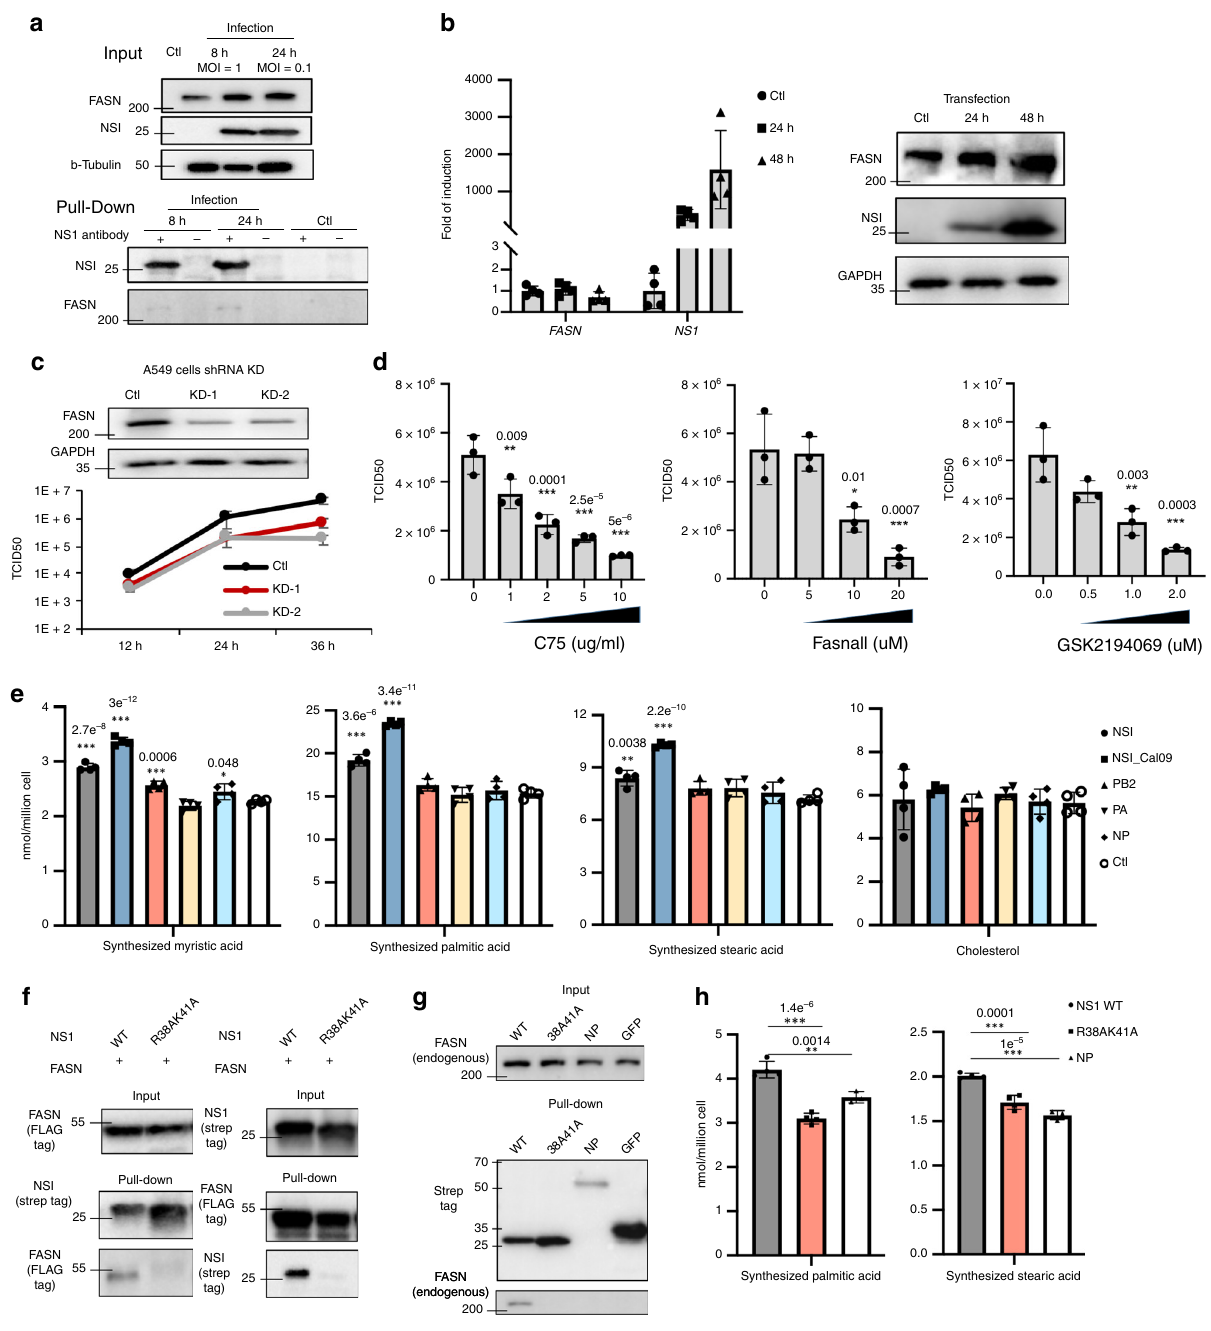
Fig. 4 FASN is required for viral replication and regulated by NS1. a Interactions between NS1 protein and FASN were examined by endogenous immunoprecipitation (IP)-western. Three biological replicates were performed, and a representative experiment is shown. b The gene expression level and protein expression level of FASN was examined post-NS1 overexpression in 293T cells ( N = 4 biologically independent samples). c The effect of FASN on viral replication was examined using shRNA knock-down (KD) in A549 cells. The expression level of FASN upon KD was examined by western blot (upper panel). Control cells or KD cells were infected with WT WSN at MOI 0.1. The viral titer in supernatant were determined using TCID50 assays ( N = 3 biologically independent samples). d The effect of FASN on viral replication in A549 cells was examined using FASN inhibitors, including C75, Fasnall and GSK2195069. Indicated concentrations of inhibitors were used at the time of infection. The effect of inhibitor treatment on viral replication at 24-h post infection was examined by TCID50 assay ( N =